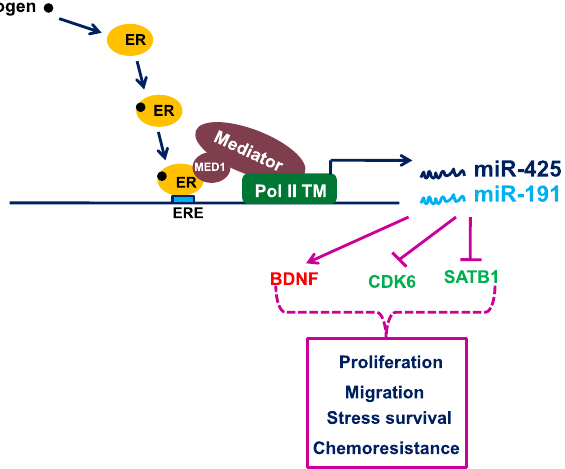
Figure 7. A proposed model detailing interplay of ER- α -MED1-miR-191/425 in breast cancer. A model for estrogen/ER- α induced MED1 mediated miR-191/425 regulation in breast